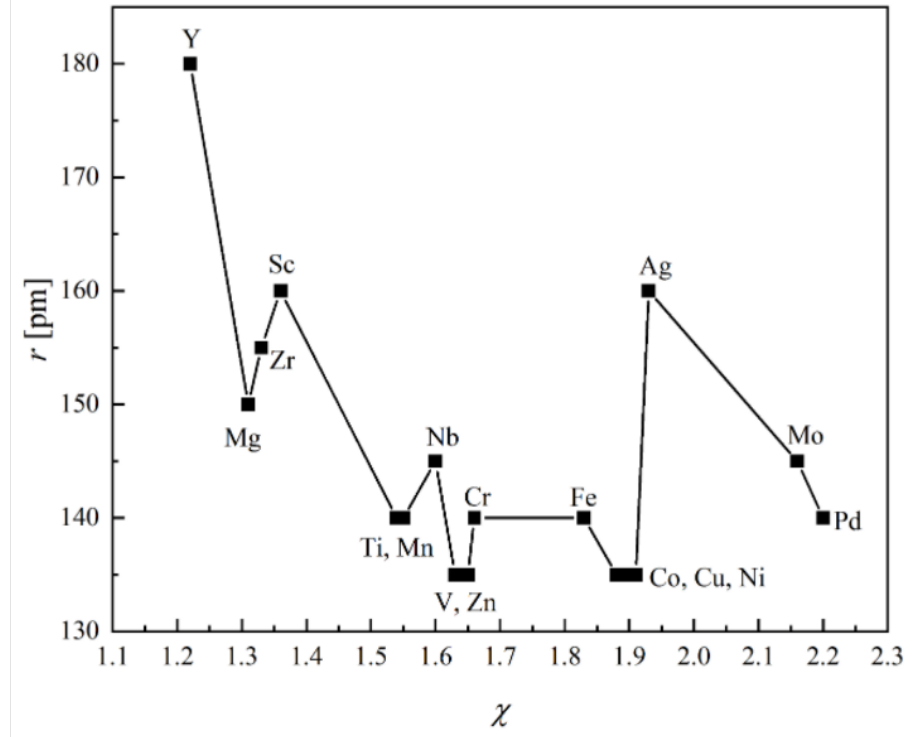
Figure 19. The empirical radiuses ( r ) and electronegativities ( χ , Pauling scale) of Mg and TM elements. The empirical radius of Mg and TM elements come from reference [125], and the electronegativity (Pauling scale) of Mg and TM elements come from reference